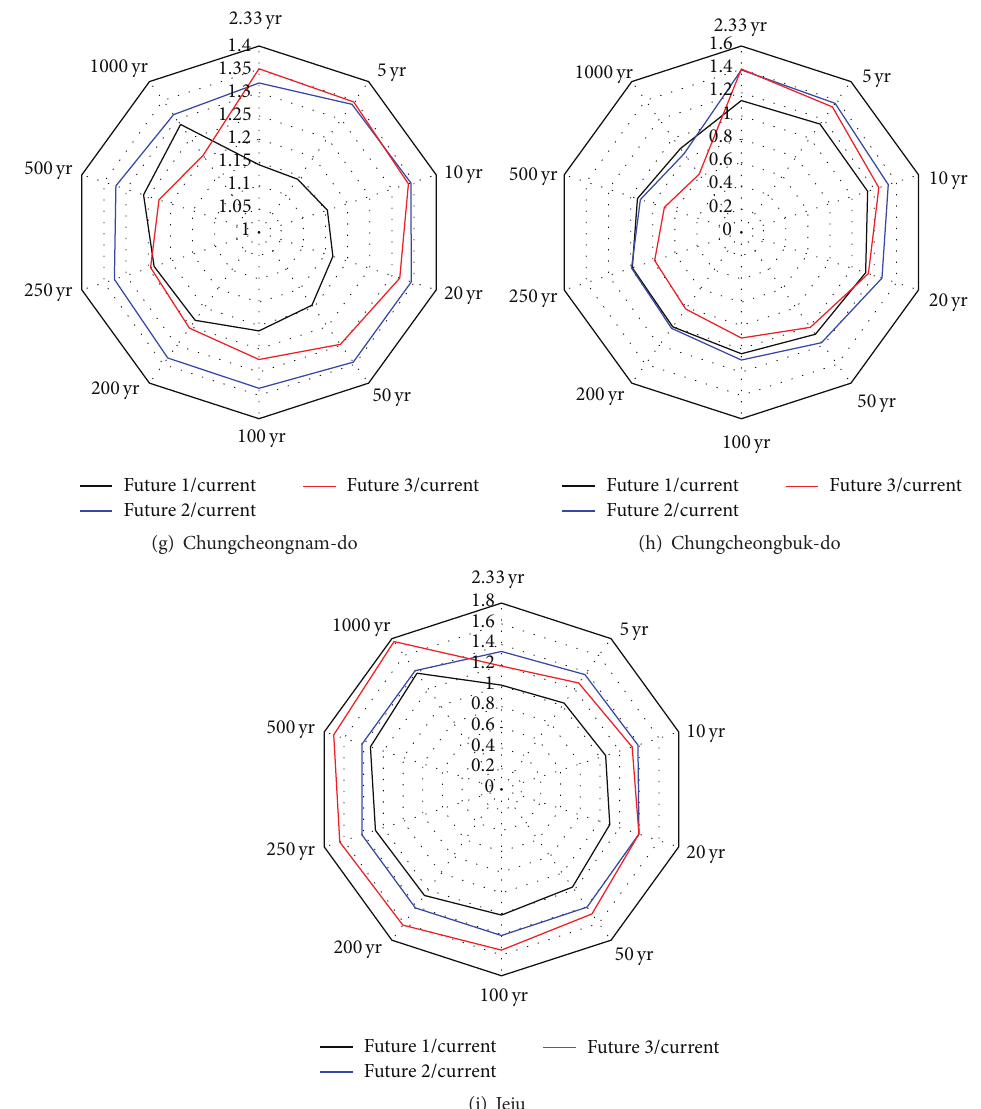
Figure 8: Ratio of maximum drought intensity in the future climate to the current